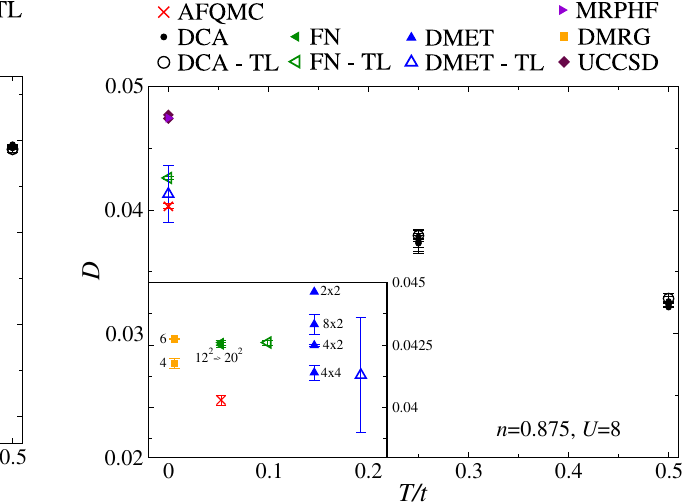
FIG. 6. Data for n ¼ 0 . 875 for U=t ¼ 8 . Main panel: Temper- ature dependence of E=t compiled from various techniques. Solid symbols represent finite systems; open symbols represent extrap- olations to the thermodynamic limit. Finite- T results are shown for DCA (black circles), and zero- T data from AFQMC (red crosses), DMET (blue triangles), UCCSD (maroon diamonds), DMRG (orange squares), and FN (green triangles). Top left inset: Zoom-in of the zero- T data from DMET, AFQMC, FN, and DMRG including finite-system-size data (as labeled).